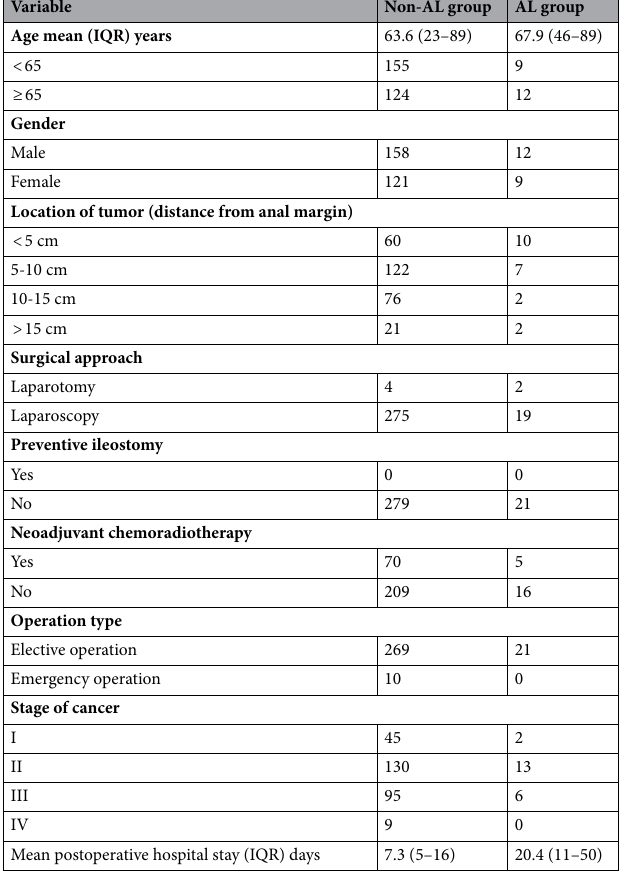
Table 1. The clinical characteristics of the patients stratified by group.